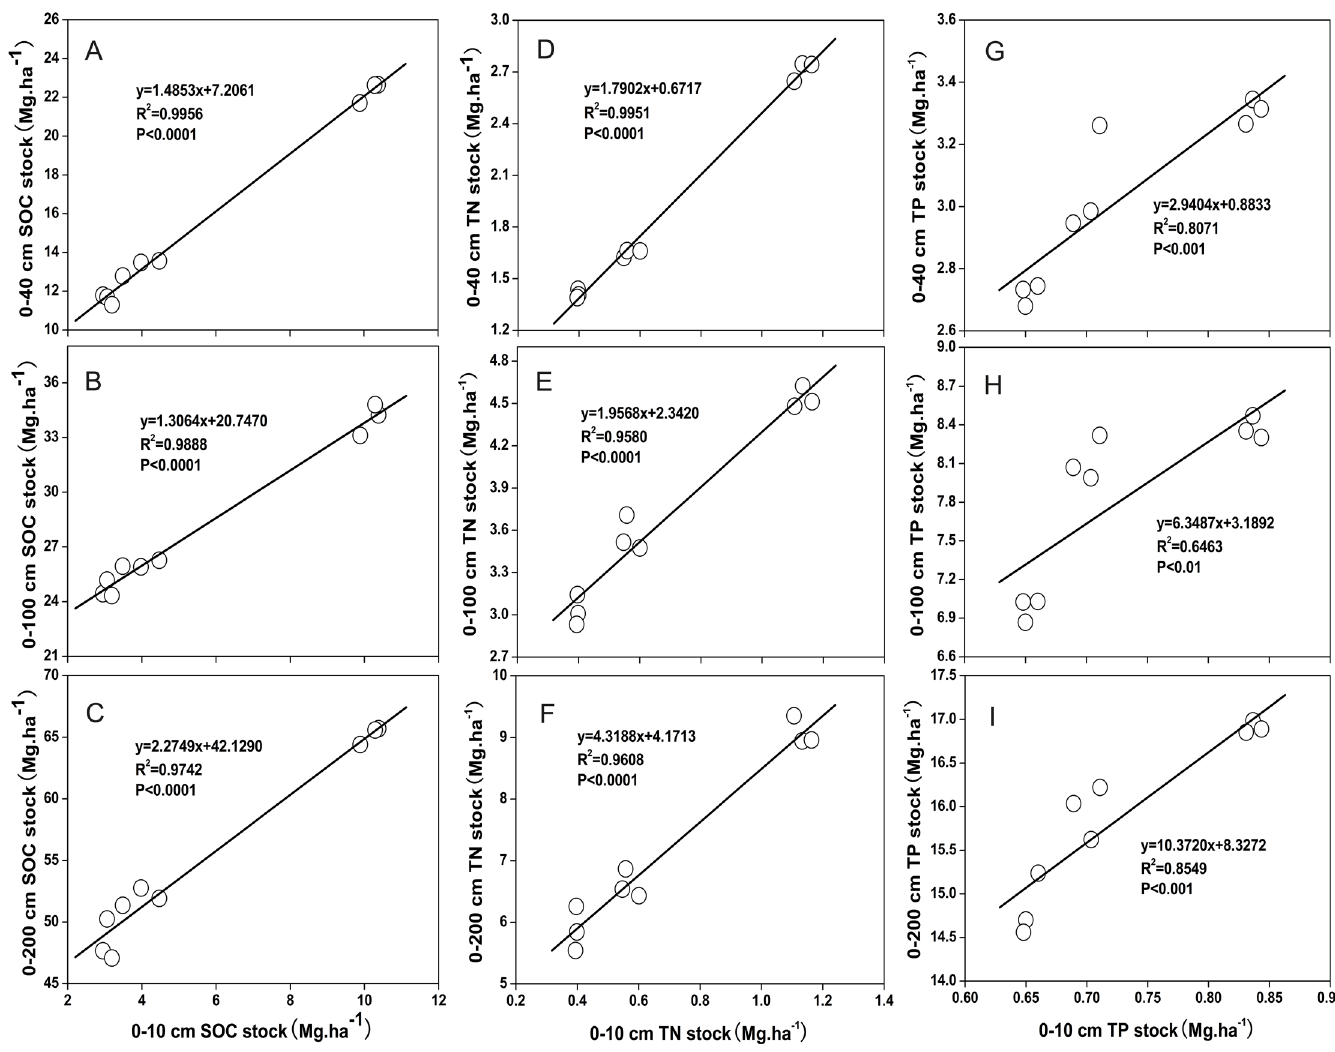
Fig 5. Relationships of SOC, TN and TP stocks between 0 – 10 cm and 0 – 40 cm, 0 – 100 cm, and 0 – 200